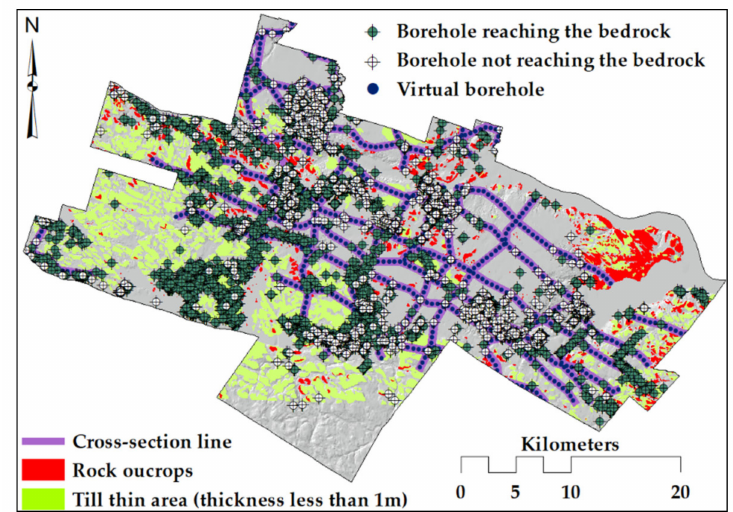
Figure 6. Complete set of the available observation points, including borehole logs, rock outcrops and shallow till